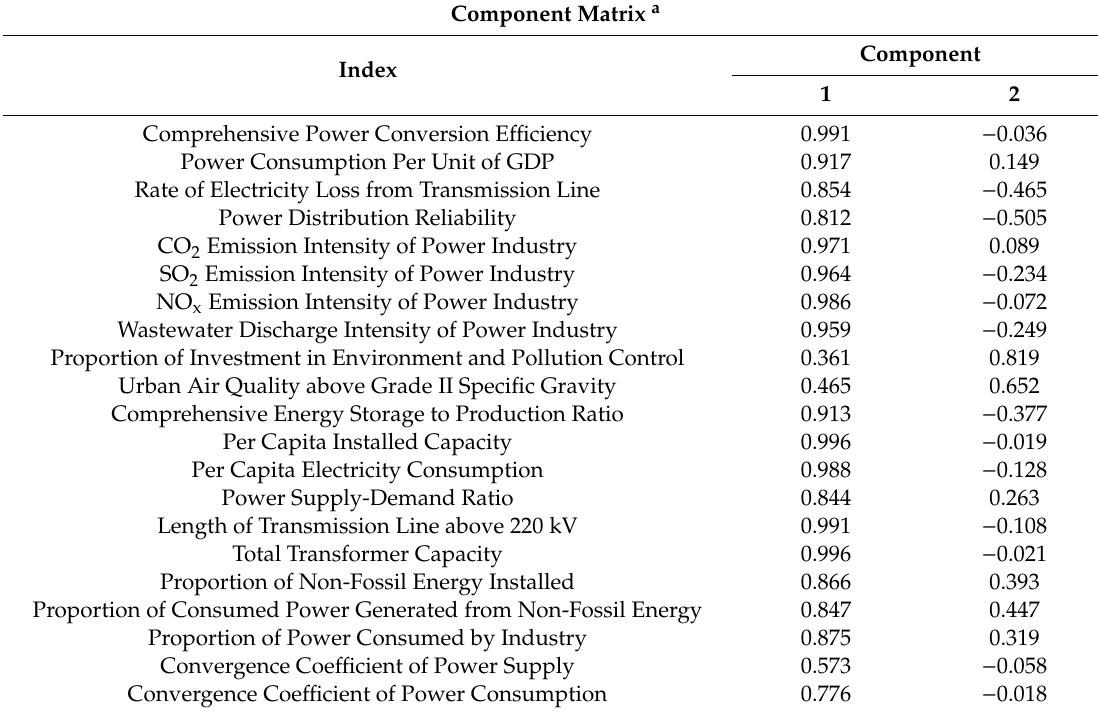
Table 4. Component Matrix.